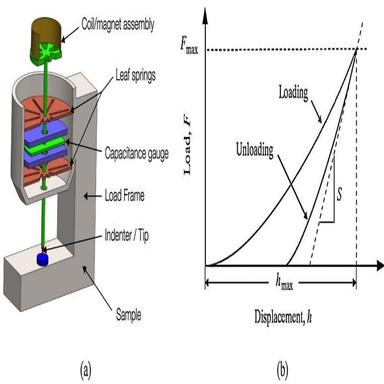
Basic instrumentation and output of nanoindentation technique (adapted from).